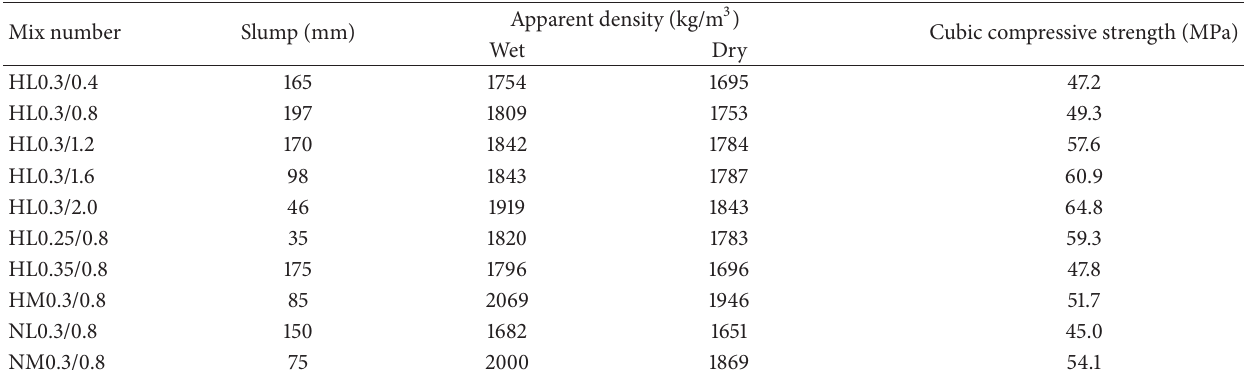
Table 6: Test results of mix slump and apparent density of SFRLAC.